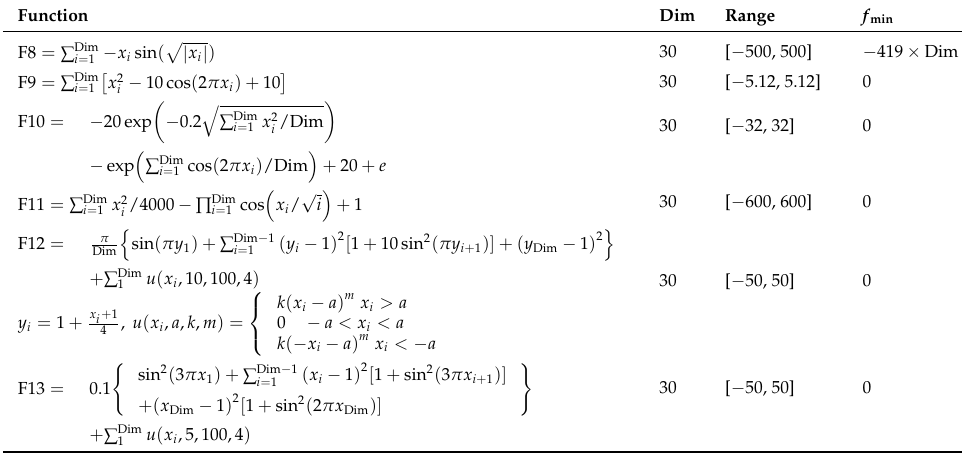
Table A2. Multimodal benchmark functions.